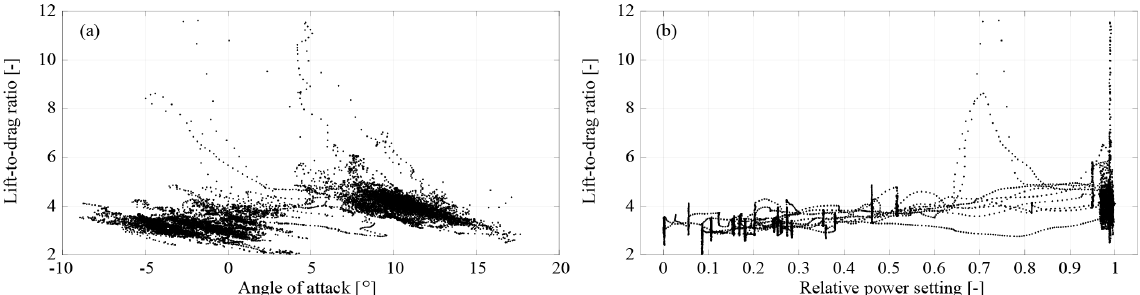
Figure 13. Measured lift-to-drag ratio L/D of the kite plotted over the angle of attack α of the wing ( a ) and relative power setting u p of the kite ( b ). No filtering or smoothing is applied to the data.